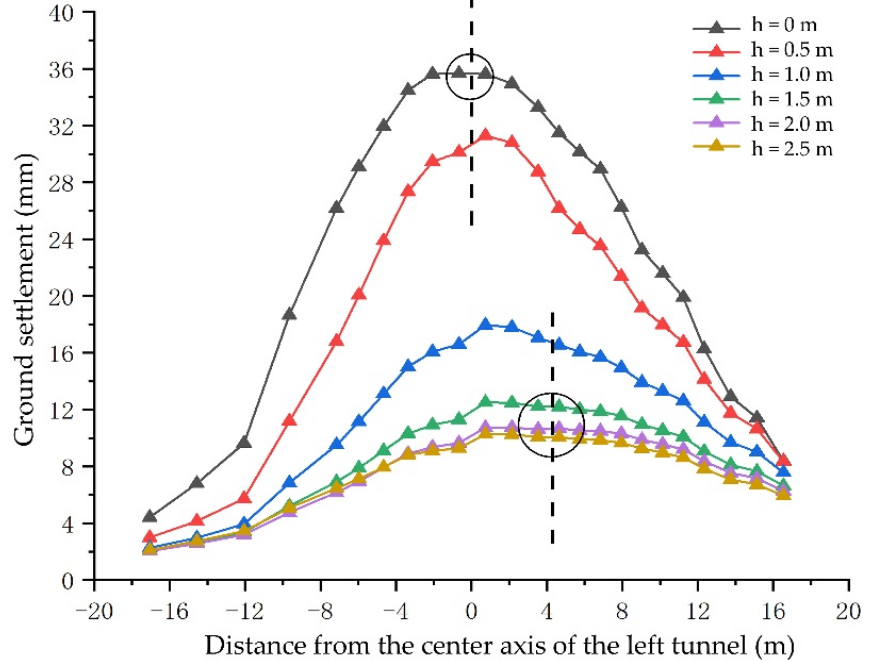
Figure 13. Ground settlement at monitoring points. Figure 14 shows the relationship between the maximum ground settlement and the grouting reinforcement layer thickness. When the thickness of the grouting reinforcement layer was h = 0 m, 0.5 m, 1.0 m, 1.5 m, 2.0 m, and 2.5 m, the corresponding maximum ground settlement was 35.7 mm, 31.3 mm, 18.0 mm, 12.5 mm, 10.7 mm, and 10.3 mm respectively, and the variation range of the maximum settlement was 4.4 mm, 13.3 mm, 5.5 mm, 1.8 mm, and 0.4 mm respectively. The maximum variation range of settlement was the largest between h = 0.5 m and h = 1.0 m, indicating that the reinforcement effect was significant when the reinforcement layer thickness h changed from 0.5 m to 1.0 m. With the increase of grouting reinforcement layer thickness, the maximum variation range of settlement decreased rapidly. When the grouting reinforcement layer thickness changed from 2 m to 2.5 m, the maximum variation range of surface settlement was only 0.4 mm and the reinforcement effect obtained was not obvious. Grouting reinforcement has a great impact on the ground settlement. The greater the thickness of the reinforcement layer, the better the reinforcement effect. Considering the maximum ground settlement and its variation range, when the thickness of the grouting reinforcement layer was h = 1.0 m and h = 1.5 m, the maximum ground settlement caused by excavation was smaller and the reduction range was large, the reinforcement effect obtained was better and the benefit was